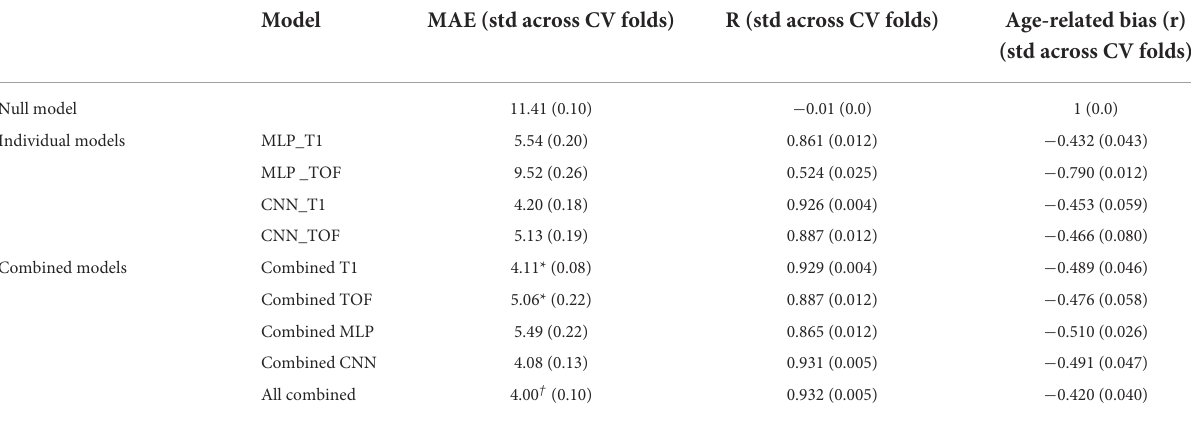
TABLE 2 Performance of the null model and of the different individual and combined